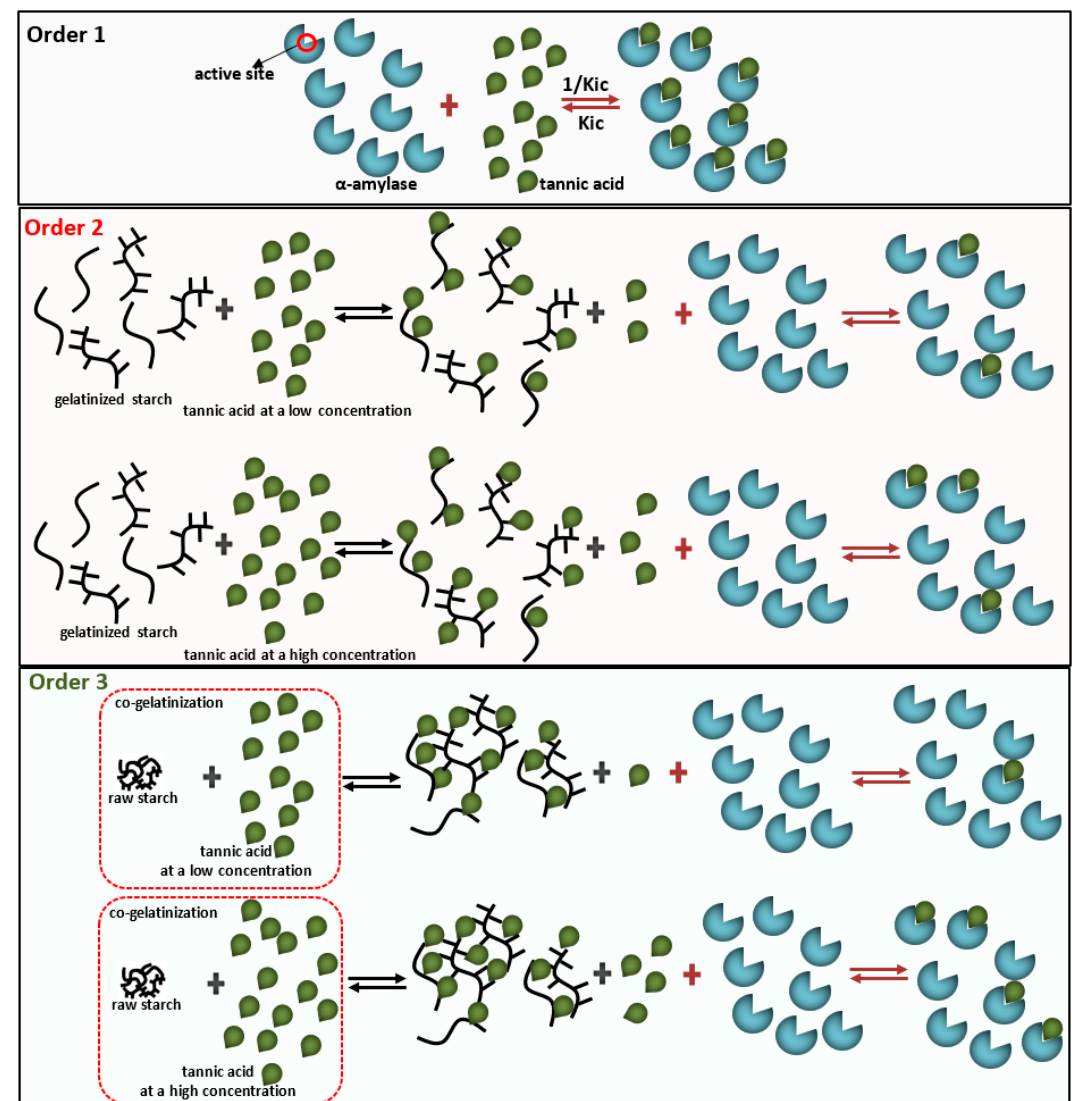
Figure 5. The scheme of effects of mixing orders (procedures) on TA-amylase binding interactions. For order 1, TA was firstly mixed with α -amylase before starch addition; therefore, TA could bind with the active site (in a competitive inhibition manner) of the enzyme thoroughly. Notably, in the binding equilibrium, K ic indicates the dissociation constant of TA-amylase complex (reforming individual TA and α -amylase); therefore, 1/ K ic suggests the binding constant of TA with the enzyme active site. For order 2, TA was firstly mixed with the pre-gelatinized starch before α -amylase addition. In this order, TA molecules were adsorbed onto the unfolded starch chains in a disordered manner, decreasing the amount of free TA molecules that could bind with α -amylase. Because the inhibition kinetics of TA for this order could still be well-fitted with the competitive Dixon and Cornish-Bowden equations that were performed at a series of starch concentrations (also a series of mass ratios of TA to starch), the adsorption of TA with pre-gelatinized starch at the low and high TA concentrations were suggested to have a similar property. For order 3, TA was mixed with raw starch and then co-gelatinized before α -amylase addition. In this order, TA had a longer contacting process and a higher interacting temperature (than order 2) with starch from the beginning of gelatinization process. Therefore, TA molecules interacted with starch chains more thoroughly (than order 2) along with the swelling of starch granules and unfolding of ordered structures, tending to form a network where TA(s) are included inside acting as a ‘bridge’ linkage of swollen starch. This decreased the binding of TA with α -amylase and the decreasing effect was higher than order 2, specially at a low TA concentration. However, with the TA concentration increasing, the incorporated TA in the network gradually reached saturation, and the entering of additional TA was retarded. By this way, the amount of unbound TA that could bind with α -amylase for this order was more than that for order 2 at a high TA